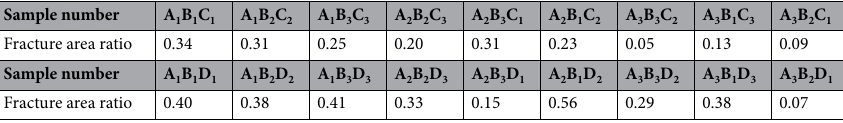
Table 9. SEM image fracture area ratio.